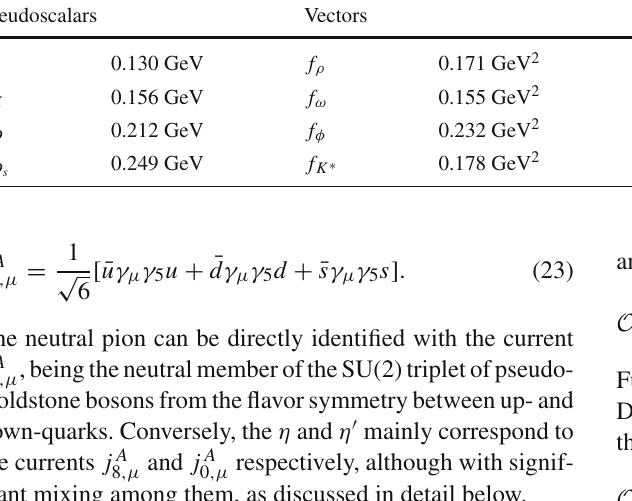
Table 1 Left. decay constants for pseudoscalar and vector mesons, defined as in Eqs. (17) and (18). The pseudoscalar decay constants are directly taken from Ref. [69], while those for vector mesons have been computed as described in Appendix C. Right. decay constants for the η η 0 and 8 , and angles that parametrize the rotation to the physical basis, Pseudoscalars Vectors Decay constants Rotation